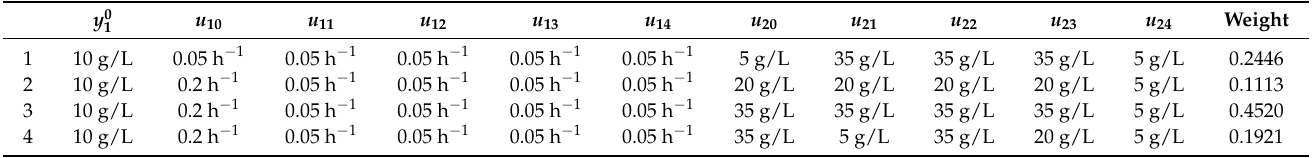
Table 12. Optimal design ξ YBT computed with the YBT algorithm for the yeast fermentation.